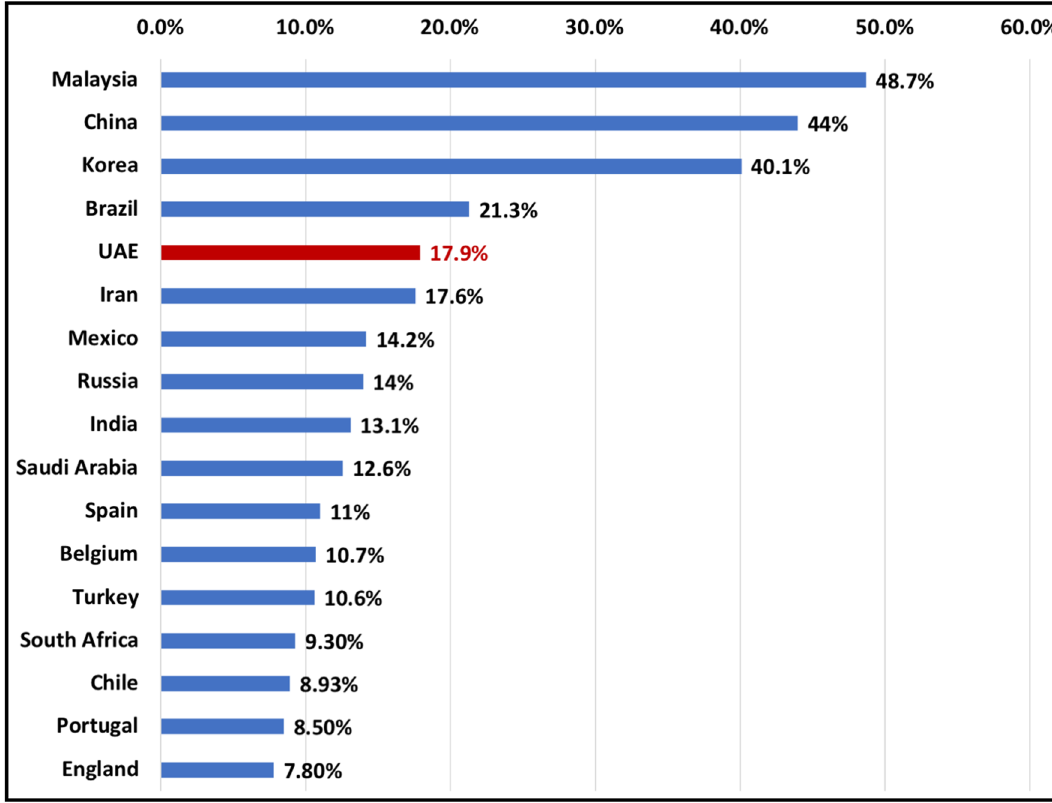
Figure 6. Bar chart indicating C-shaped mandibular second molar prevalence in different populations. These studies were conducted using